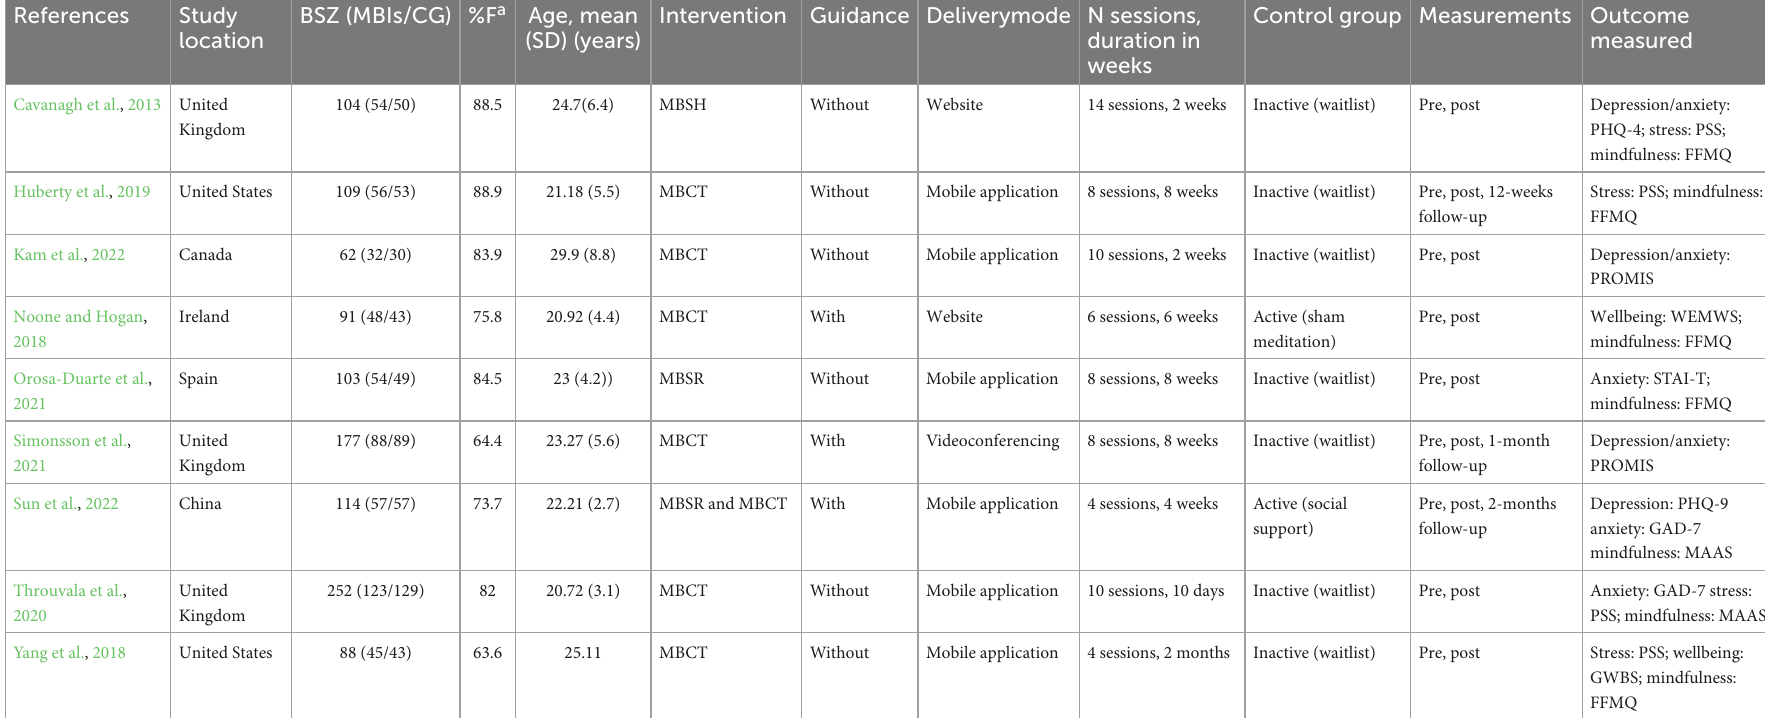
TABLE 1 Characteristics of included